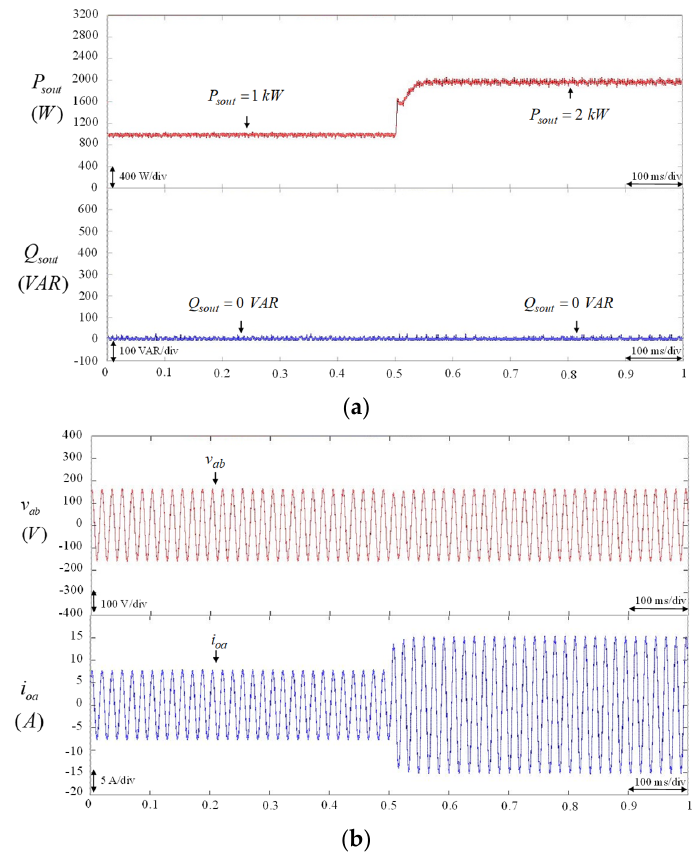
Figure 5a–c. The responses of the real power output P and the reactive power output sout of the BESS are shown in Figure 5a. The responses of the line-to-line voltage v Q sout ab and the output current i oa of the BESS are shown in Figure 5b. The response of the virtual rotor frequency f of VSG control is provided in Figure 5c. According to the experimental sm results, shown in Figure 5a–c, since the virtual inertia J = 0 kgm 2 was adopted in the s VSG control of the BESS, the characteristics of the BESS using VSG control were similar to the BESS using droop control under load variation [6]. Hence, the real power output , output current i oa , and virtual rotor frequency f respond rapidly. Moreover, the P sm sout experimental results of the BESS using VSG control with J = 0.002713 kgm 2 are provided s in Figure 6a–c. The responses of the real power output P and the reactive power output sout of the BESS are shown in Figure 6a. The responses of the line-to-line voltage v Q sout ab and the output current i oa of the BESS are shown in Figure 6b. The responses of the virtual rotor frequency f of the VSG control and the virtual inertia J are provided sm s in Figure 6c. From the experimental results as shown in Figure 6, although a virtual inertia of J = 0.002713 kgm 2 was adopted in the VSG control, the oscillation phenomena of s the real power output P , output current i oa , and virtual rotor frequency f seriously sm sout deteriorate the control performance of the BESS under load variation owing to the low moment of virtual inertia [15]. Furthermore, the experimental results of the BESS using VSG control with J = 0.00407 kgm 2 and J = 0.0407 kgm 2 are represented in Figures 7 and 8, s s respectively. In accordance with the experimental results shown in Figures 7 and 8, the larger the moment of virtual inertia J , the more sluggish the response of the oscillations s of real power output P , output current i oa , and virtual rotor frequency f . Therefore, sm sout from the experimental results shown in Figures 5–8, when the amount of virtual inertia in the VSG is unsuitable, oscillations in the real power output and frequency of the BESS will occur under load variation.